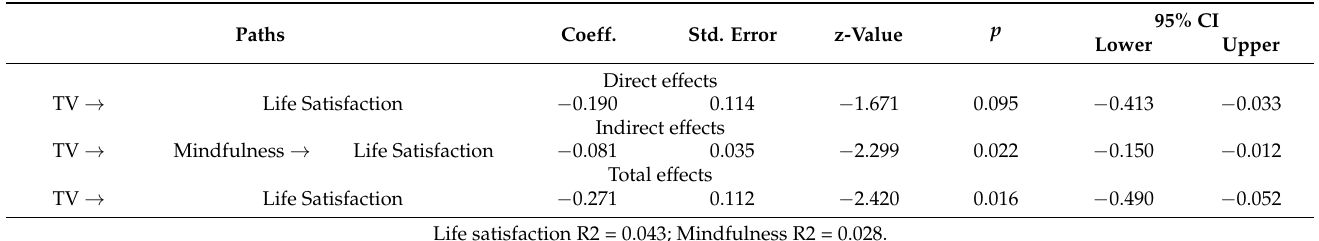
Table 15. Mediation analysis results in the total sample of respondents: the role of mindfulness as a